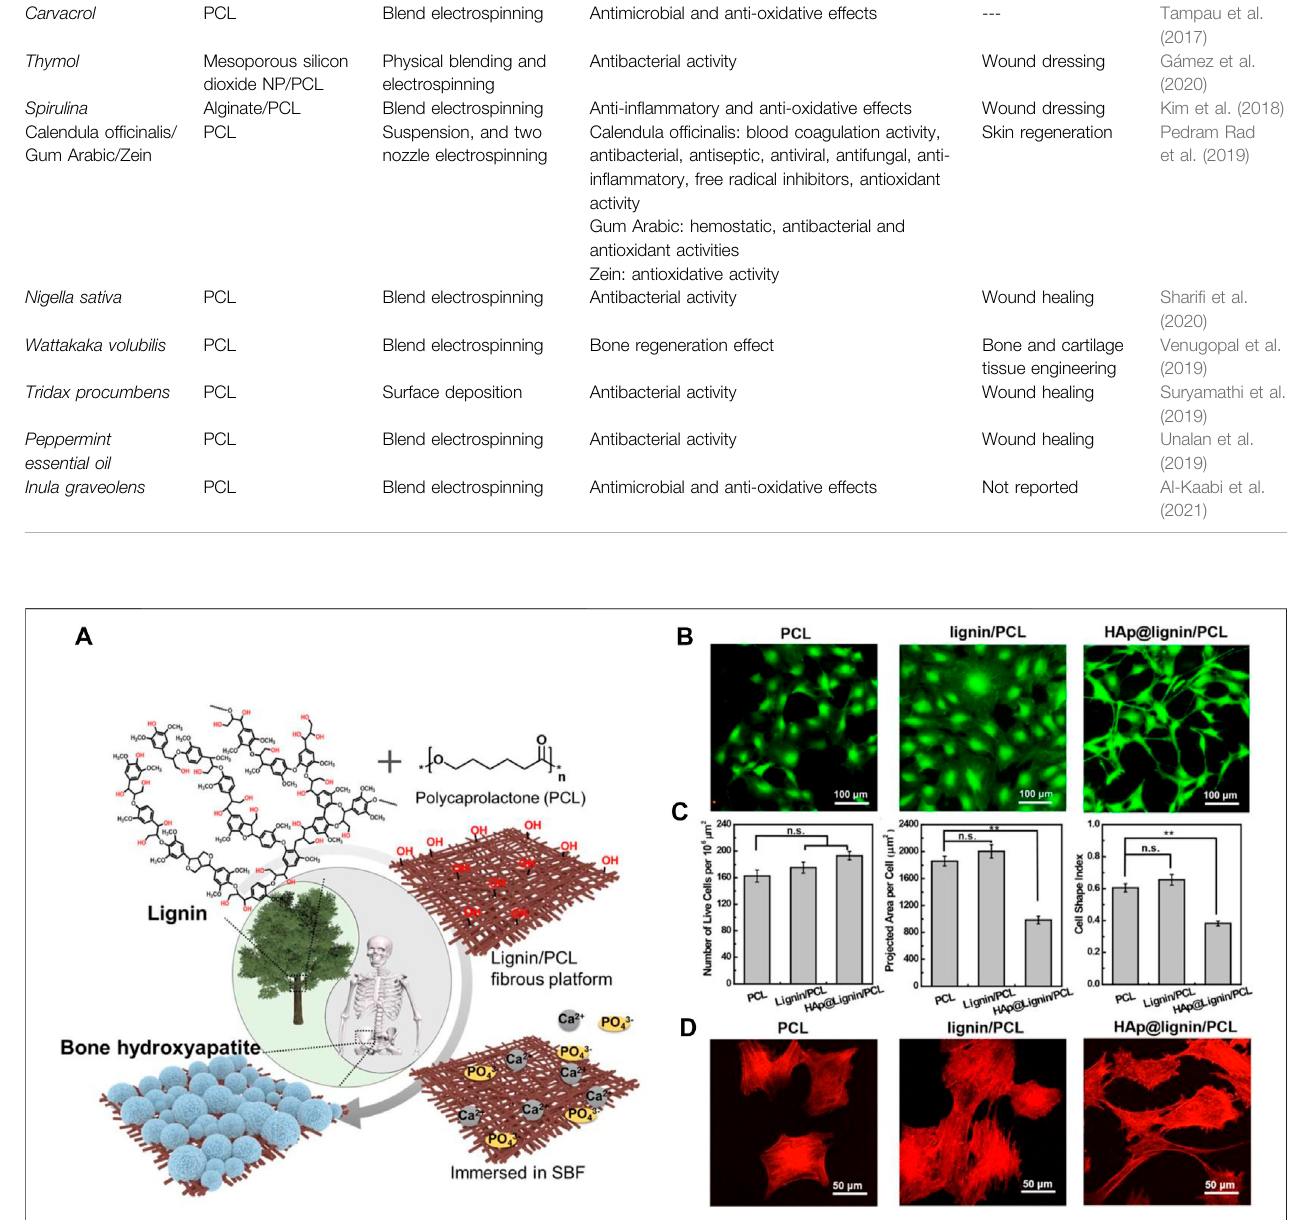
TABLE 4 | Bioderived compound loaded PCL nano fi bers for biomedical applications (studies carried out since 2017). Bioderived compound